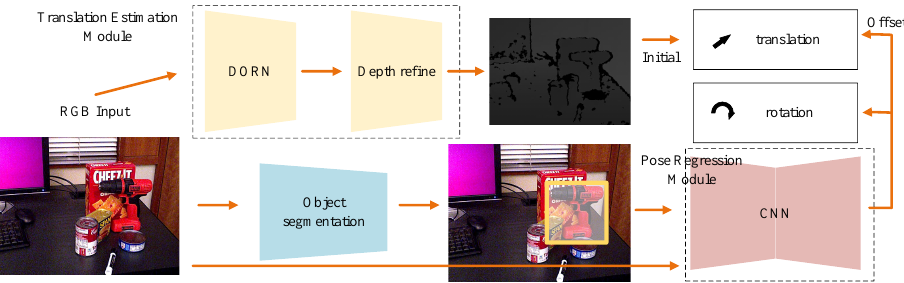
Figure 2. Overview of Our 6D Pose Regression Network. Our network generates object bounding boxes and masks through a segmentation network. The translation estimation module produces initial t , and CNN is a pose regression module, which produces R and the offset of t